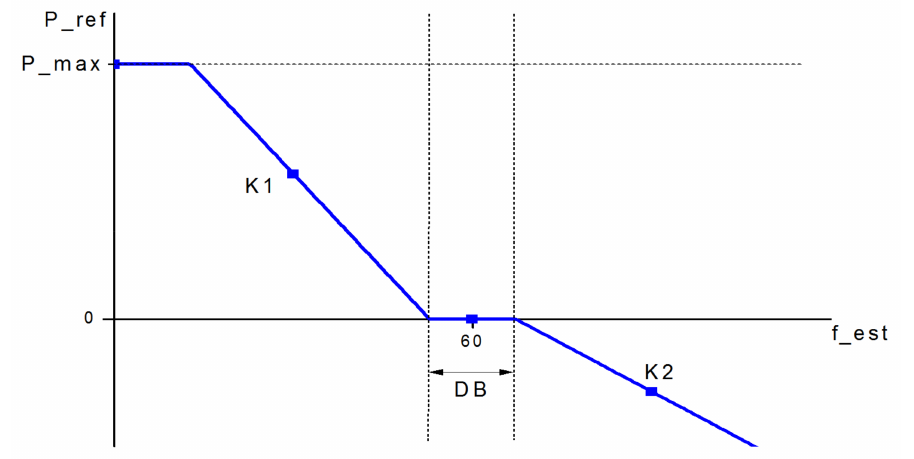
Figure 2. Battery energy storage system (BESS) output with Frequency Droop Control (FDC) according to the power system frequency [14].